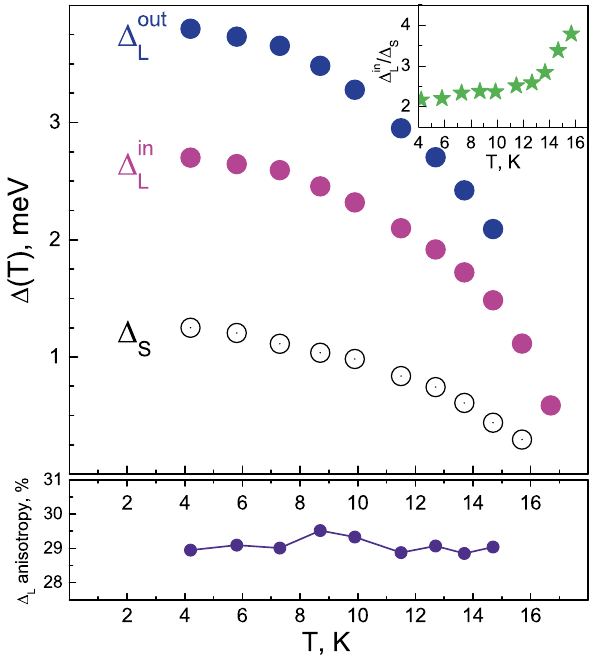
Fig. 3 Temperature dependences of the superconducting gaps for the array ♯ 1 shown in Fig. 2. The Δ out L ( T ) and Δ in L ( T ) gap edges are shown by solid blue and magenta circles, respectively, the small gap Δ S ( T ) dependence—by open black circles. The inset shows the ratio between Δ in L and Δ S versus temperature (stars). In the lower panel, the temperature dependence of the Δ L -gap anisotropy is shown (violet circles), taken as A ( T ) ≡ 100 % ⋅ [ 1 −